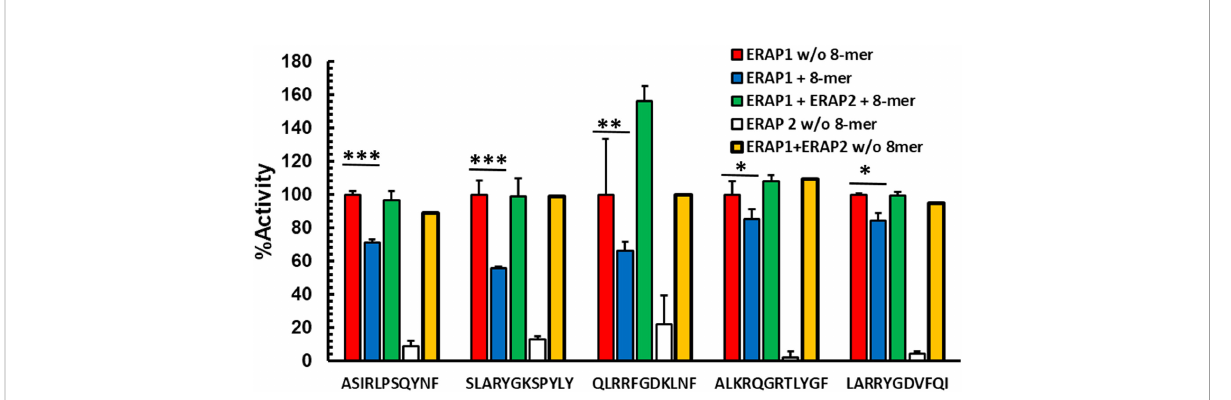
FIGURE 2 Destruction of octamers by ERAP2 rescues octamer-dependent ERAP1 inhibition Peptides were incubated with ERAP1 at an E: S 1:10 (red), ERAP2 (white) or ERAP1 plus ERAP2 (yellow), in the presence of 100 m M RYQKSTEL (blue) and in presence of inhibitor plus ERAP2 (green) at 32 min. Yields are relative to the total amount of peptide estimated as the added intensity of ion peaks corresponding to each peptide species by MALDI-TOF MS spectrometry of fi nal reaction products. The data are mean +- SD of 3 experiments. t-test analysis provided statistical signi fi cance for mean comparisons (P < 0.05). *** extremely signi fi cant, ** very signi fi cant and * signi fi